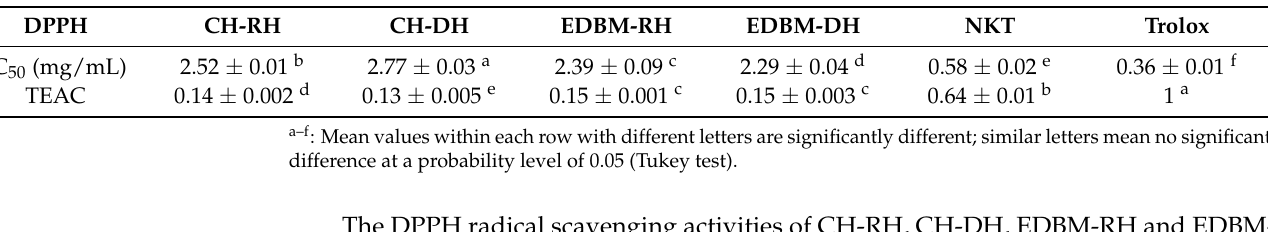
Table 4. IC 50 and Trolox equivalent antioxidant capacity (TEAC) coefficients of bovine hemoglobin hydrolysates for the DPPH